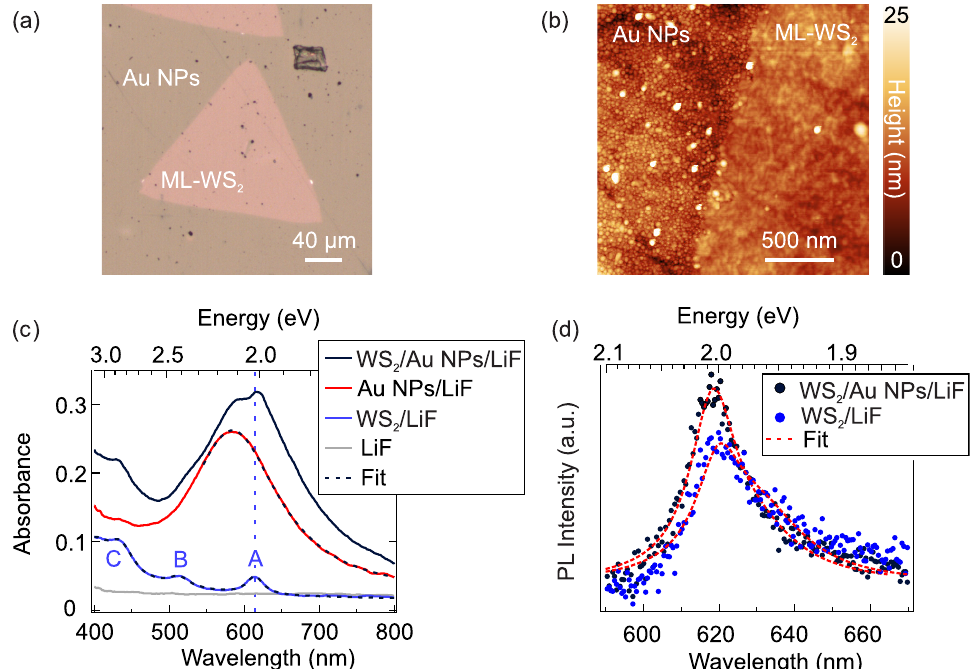
Figure 1. ( a ) Optical image of CVD-grown ML-WS 2 flake on top of Au NPs on LiF substrate. No LiF spacer is present in this region. The image was taken with a 10 × objective. ( b ) AFM image of the edge region between Au NPs and ML-WS 2 /Au NPs. The scanned area is 2 × 2 µ m 2 . ( c ) Micro-absorbance spectra of LiF substrate (grey), ML-WS 2 /LiF (blue), Au NPs/LiF (red) and of the hybrid system ML- WS 2 /Au NPs/LiF (solid black). The black dashed lines are the fitting curves of the absorbance spectra of WS 2 /LiF and Au NPs/LiF. The resonance features in ML-WS 2 correspond to A, B and C excitons. The vertical dashed blue line indicates the A exciton spectral position of ML-WS 2 . ( d ) Micro-PL spectra of ML-WS 2 /Au NPs/LiF (black circles) and ML-WS 2 /LiF (blue circles). The dashed red lines correspond to the fitting